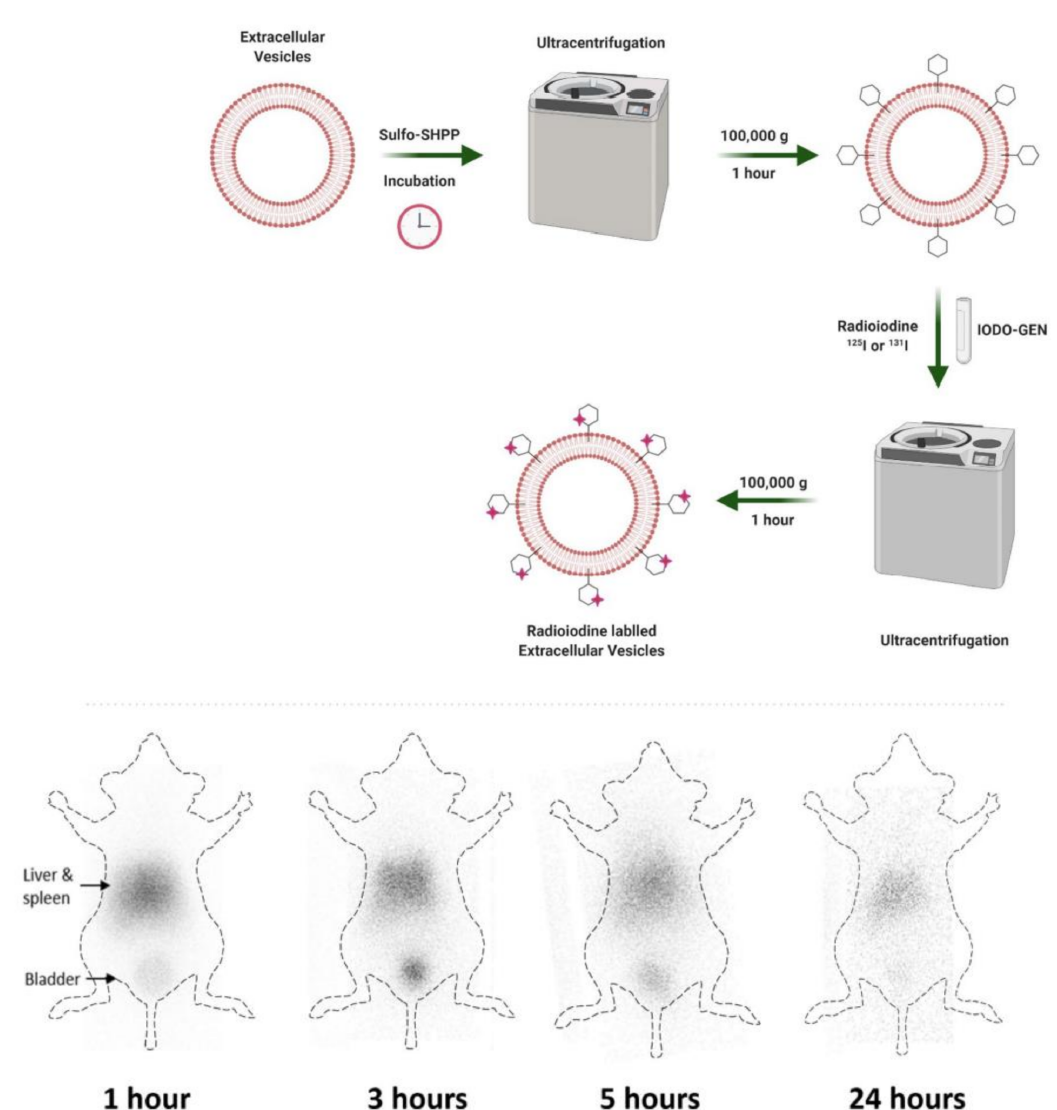
Figure 3. ( top ) Schematic of radioiodine labeling of extracellular vesicles. ( bottom ) In vivo imaging of I-131-Cal62-EVs. After intravenous injection of I-131-Cal-62-EVs (3.7 GBq), gamma camera images were acquired at 1 h, 3 h, 5 h, and 24 h in BALB/c nude mice. The gamma camera images showed intense uptake in liver and spleen areas. There was intense trace accumulation in the bladder. Reprinted from ref.